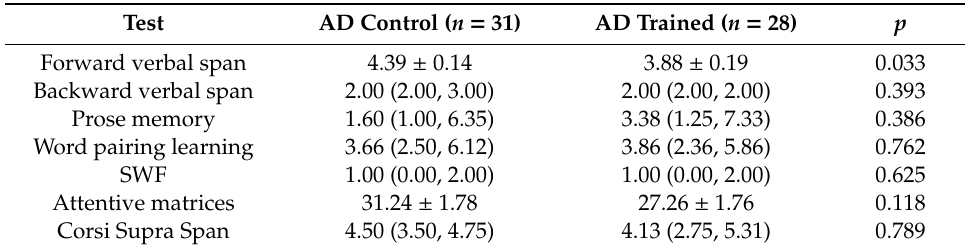
Table 2. Cognitive assessment of control and trained Alzheimer’s disease (AD) patients at baseline. Test AD control ( n = 31) AD trained ( n = 28)